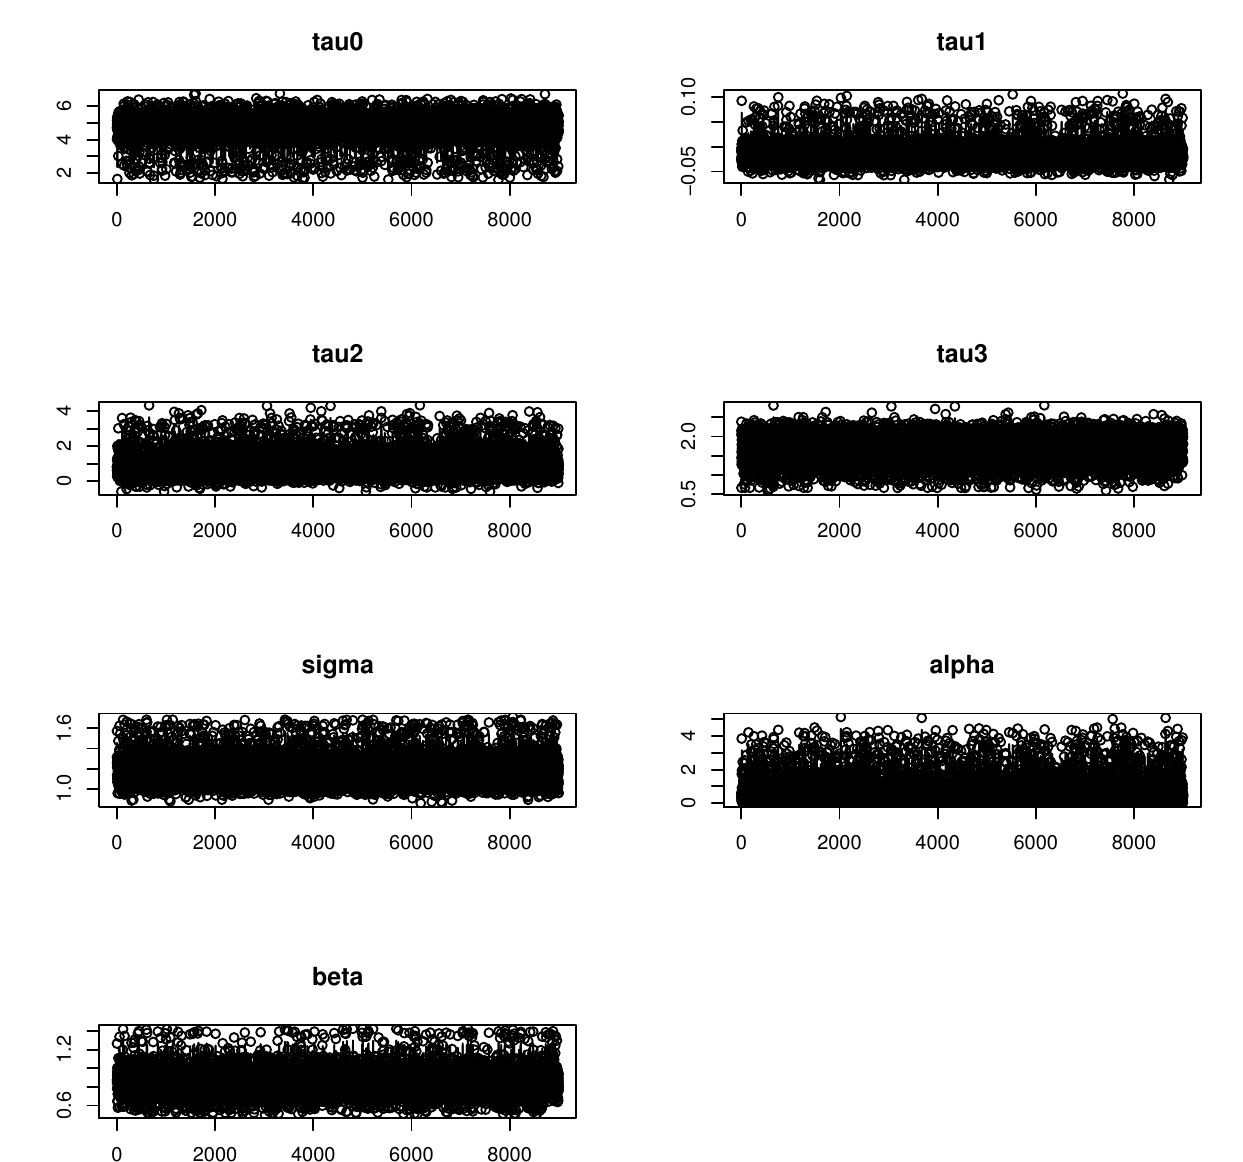
Figure 11. Trace plots of Bayesian analysis and performance of Gibbs sampling for the each parameter of LATOLLW distribution based on the heart transplant